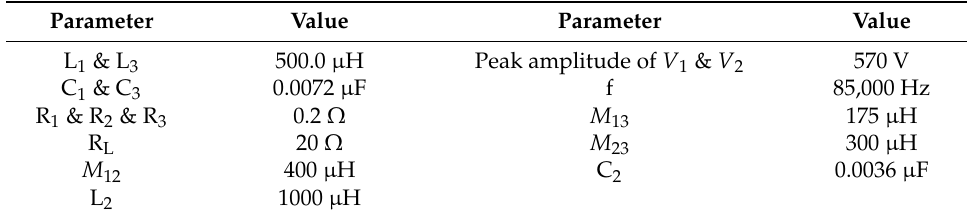
Table 1. Parameters of the system.